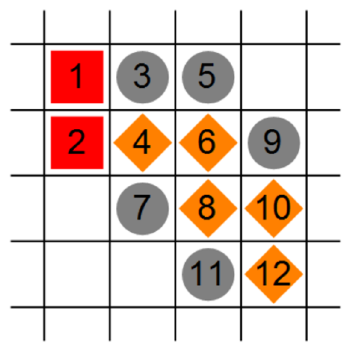
Figure 23 . Elementary patches on the